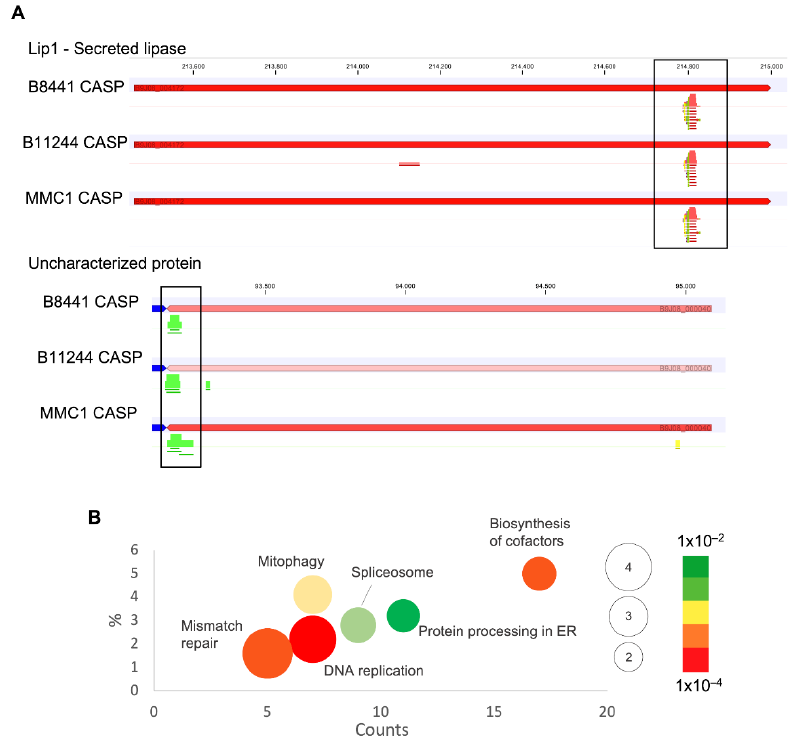
Figure 4. anti-sense RNAs present in C. auris EVs. ( A ) Specific regions of reads aligning in transcripts from EVs isolated after caspofungin treatment, in red reverse reads, and in green forward reads. ( B )